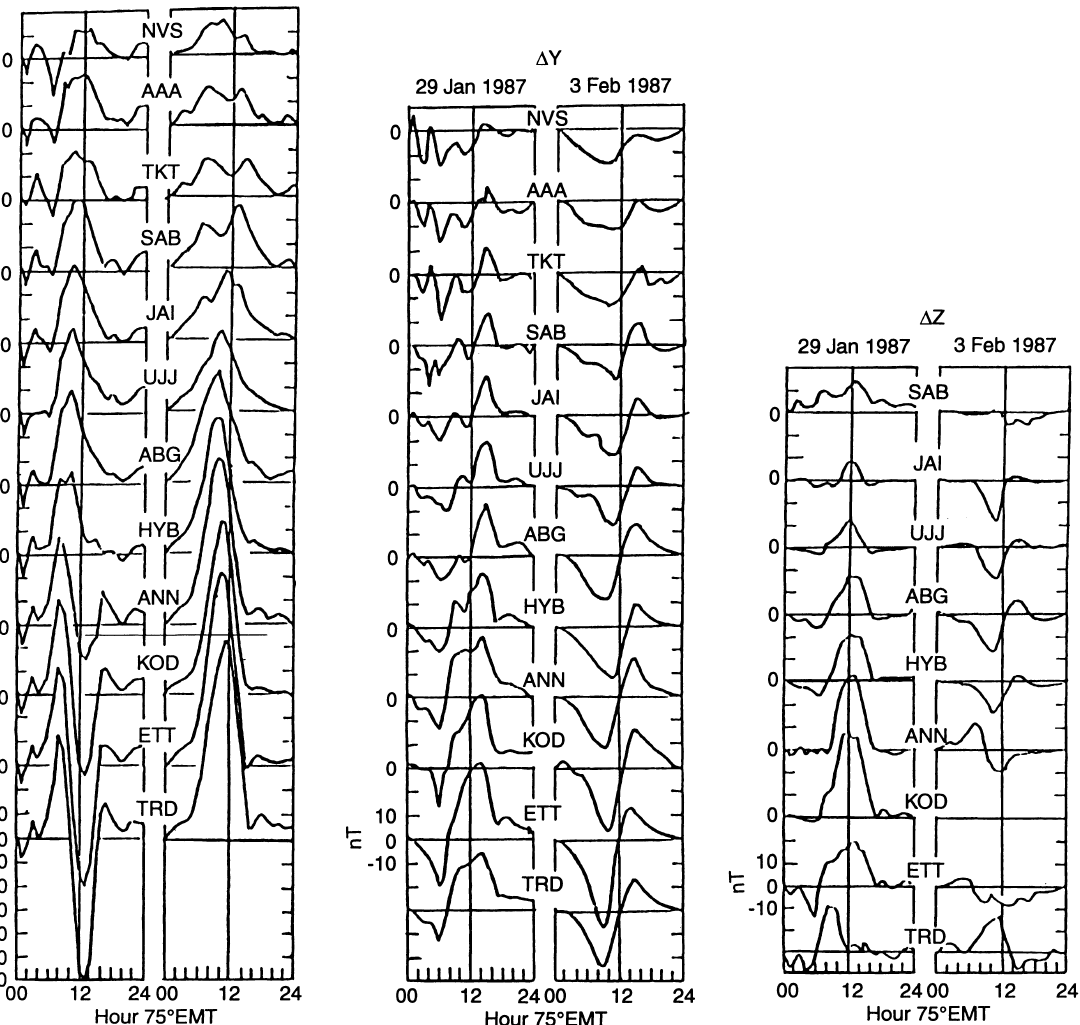
Fig. 5. a Daily variations of H field at each of the stations on 29 January and 3 February, 1987. b Daily variation of Y field at each of the stations on 29 January and 3 February, 1987. c Daily variations of Z field at each of the stations on 29 January and 3